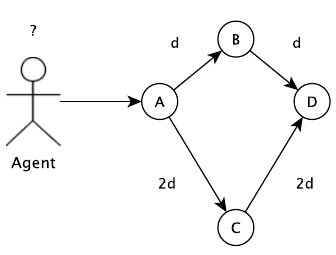
Figure 4. An overview of the main hypothesis of this work. Branches have different